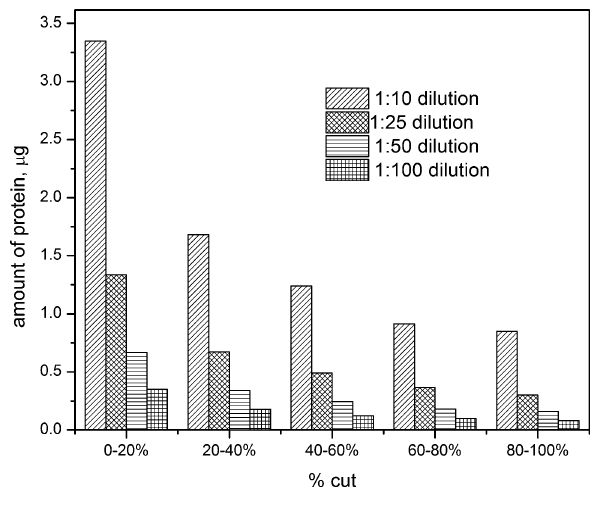
Fig. 2 Amount of protein in µ g for different cuts at different dilutions for baby corn